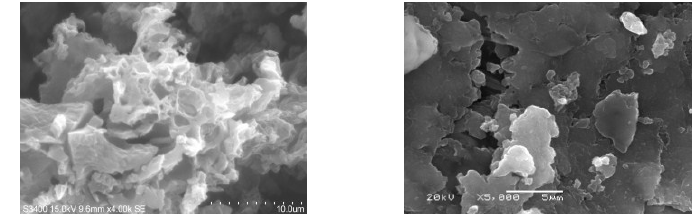
Figure 4. Scanning electron microscopy (SEM) images of for BF